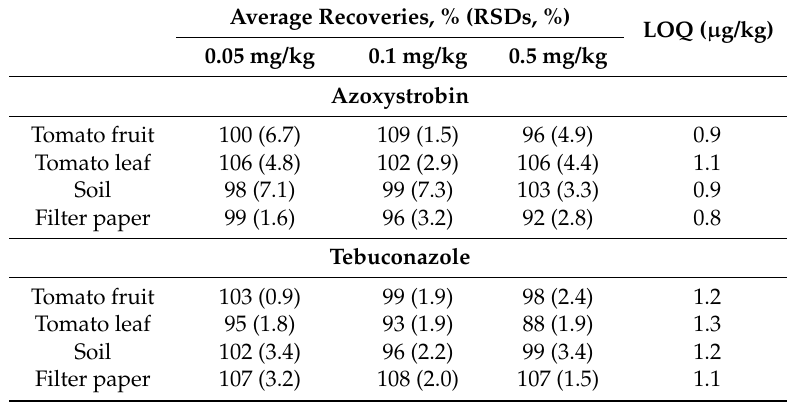
Table 2. Average recoveries (%), relative standard deviations (RSDs, %), and limit of quantifications (LOQs) of azoxystrobin and tebuconazole at varying fortification concentrations in the test matrices ( n = 3). Average Recoveries, % (RSDs, %) LOQ ( µ g/kg) 0.05